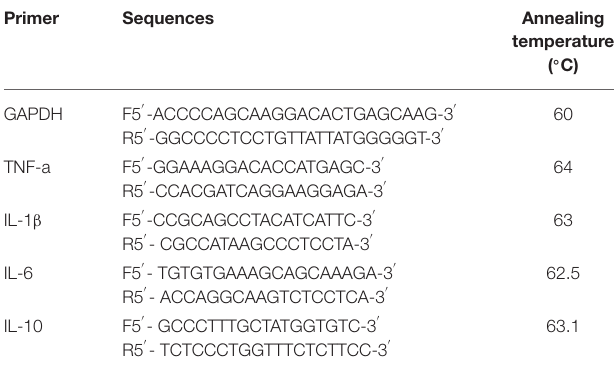
TABLE 1 | Sequences and amplification conditions for RT-PCR